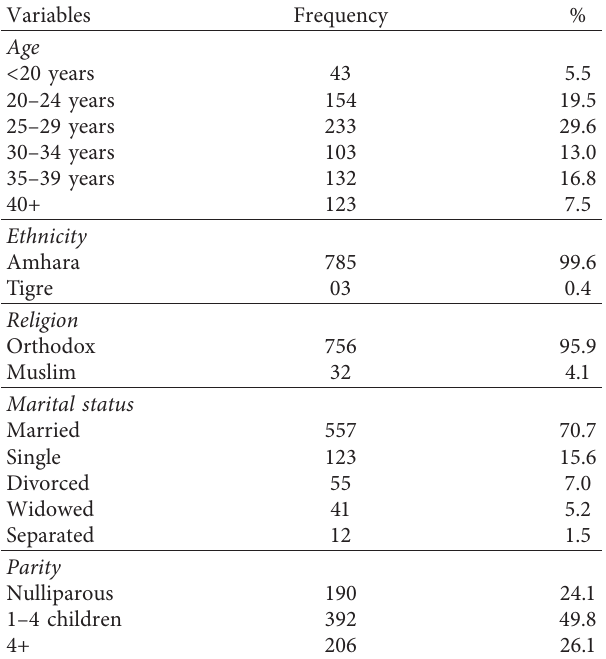
Table 1: Percentage distribution of the study population by se- lected sociodemographic variables, Dabat, Ethiopia,